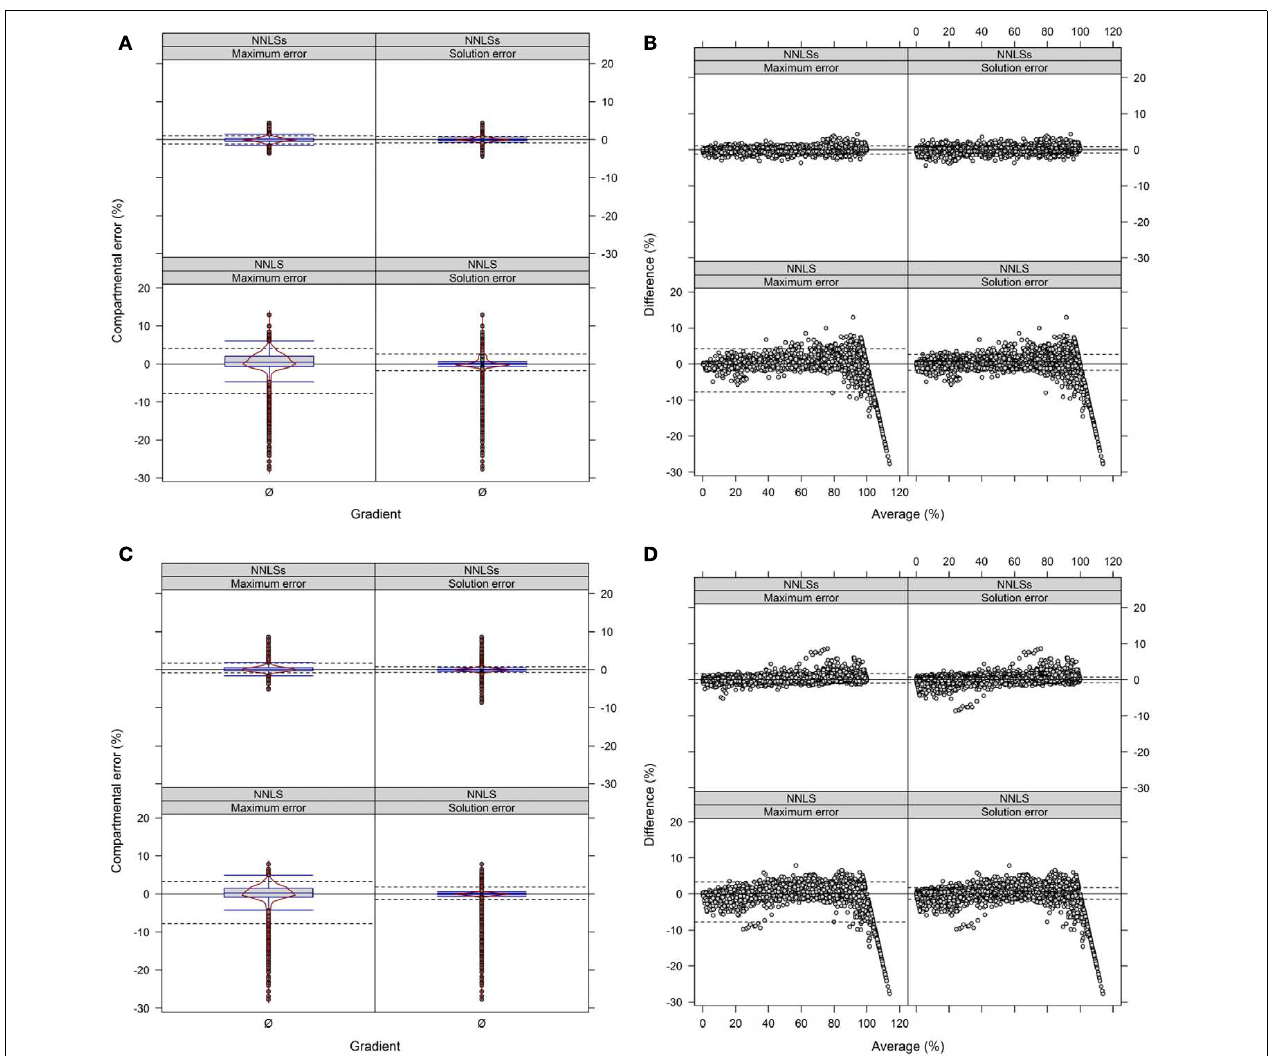
abundances. For all graphs the difference in compartmental abundances between BFA and NNLS or iterative (seed-based) (NNLSs) are visualized based on the mean–average of compartmental abundances for the three independent gradients.The 5th and 95th percentiles are drawn as black dashed lines. All values are shown, regardless if they are considered as sufficiently explained or